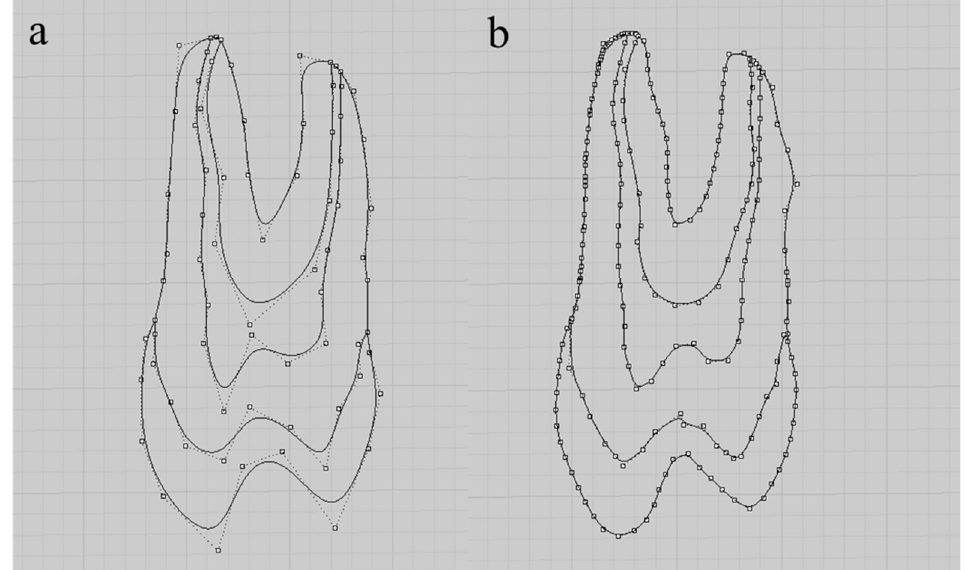
Figure 1. Continuous elements in two dimensions profile (2D). Legend: ( a ) row optimization; ( b ) polyline command.